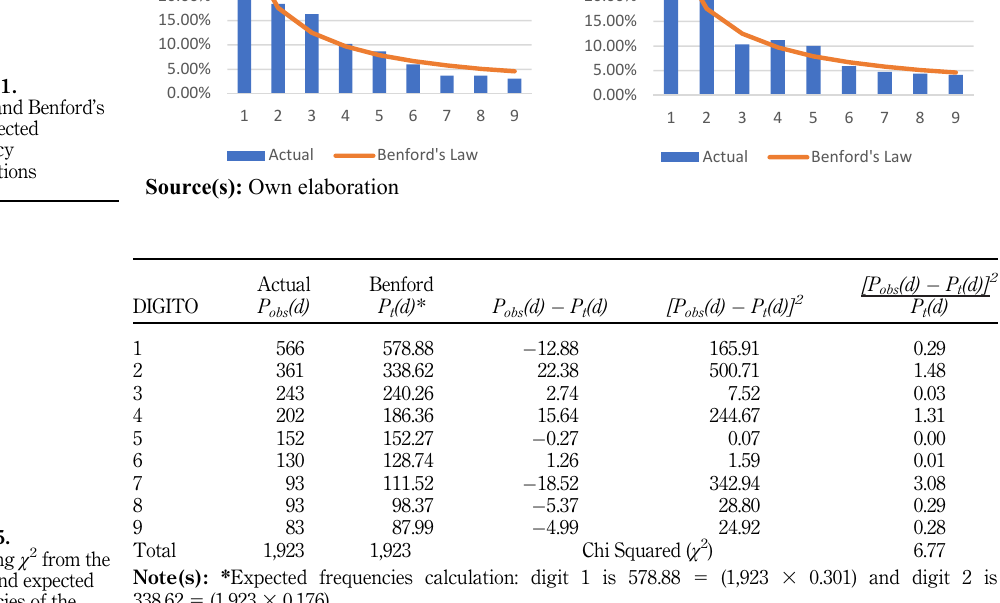
Table 5. Obtaining χ 2 from the actual and expected frequencies of the